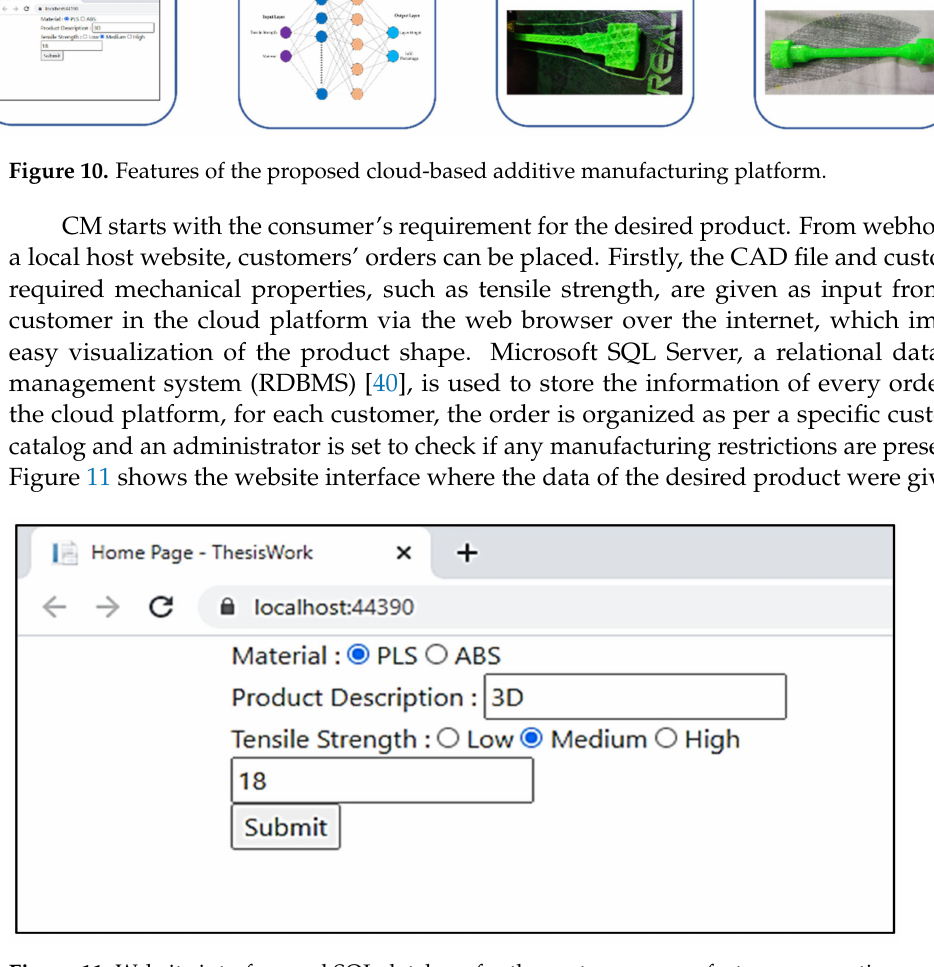
Figure 11. Website interface and SQL database for the customer–manufacturer